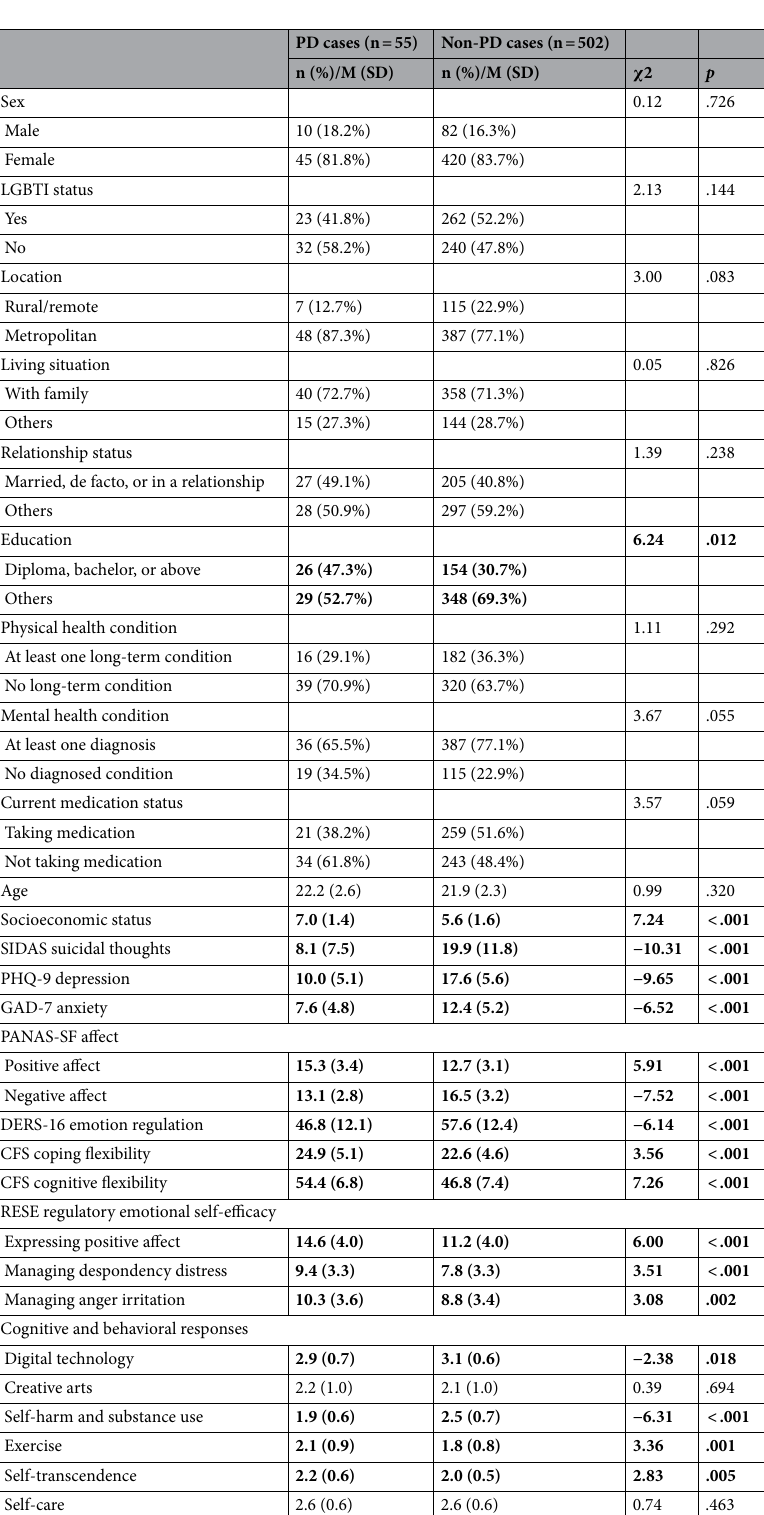
Table 3. Characteristics of the participants based on class (n = 557). M: Mean; SD: standardized deviance; PD: positive deviant; LGBTI: lesbian, gay, bisexual, trans, and/or intersex; SIDAS: Suicidal Ideation Attributes Scale; PHQ-9: The Patient Health Questionnaire-9; GAD-7: General Anxiety Disorder-7; PANAS-SF: Positive and Negative Affect Schedule-Short Form; DERS-16: The Difficulties in Emotion Regulation Scale-16; CFS: Coping Flexibility Scale; CFS: Cognitive Flexibility Scale; RESE: Regulatory Emotional Self-efficacy Scale; Bold values indicate p < 0.05 based on independent groups t-tests for continuous variables and χ 2 tests for categorical variables, comparing PD and non-PD